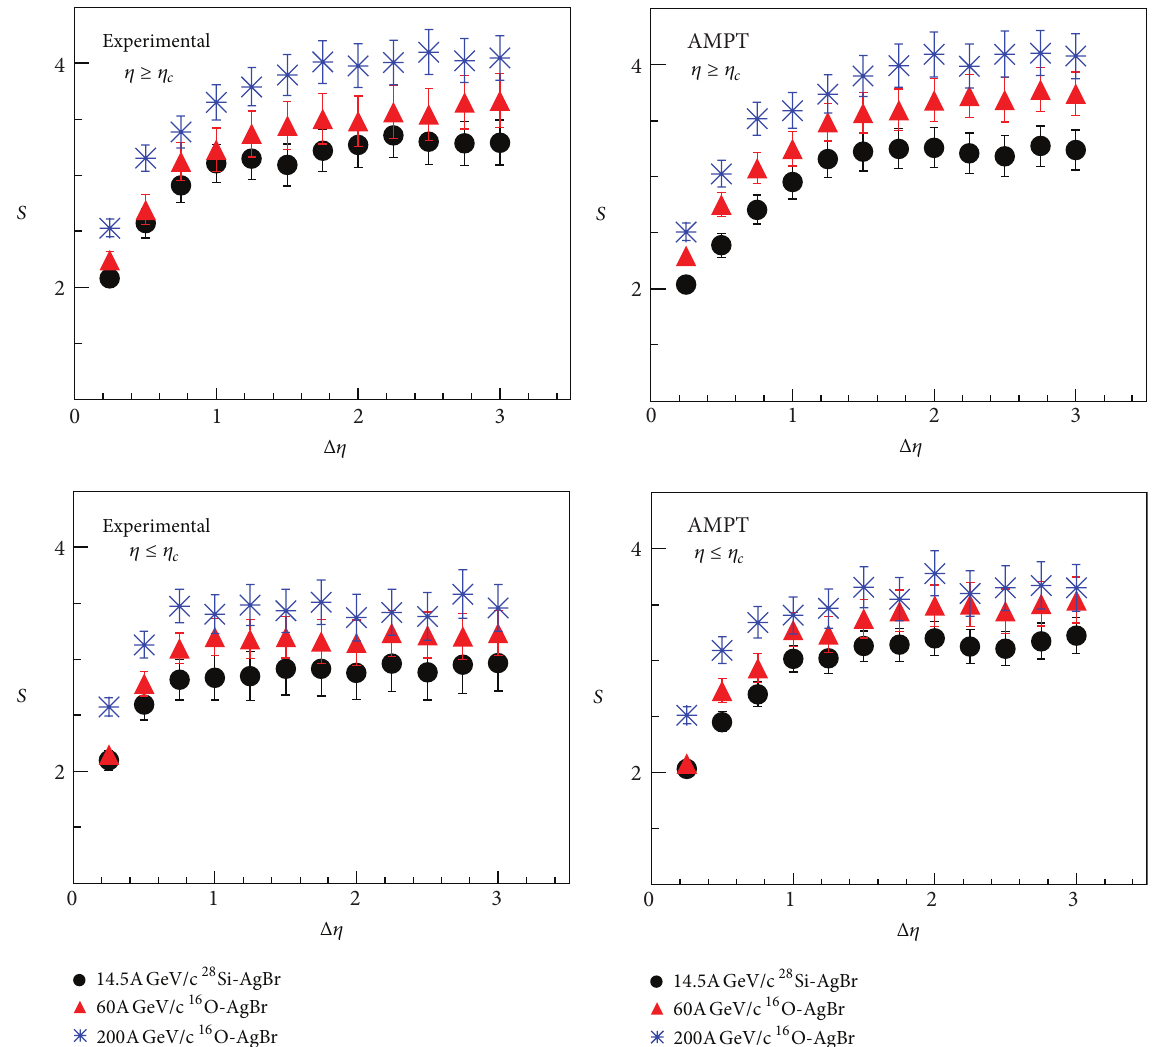
Figure 3: Variations of 𝑆 with Δ𝜂 for the experimental and AMPT events in forward and backward hemispheres.